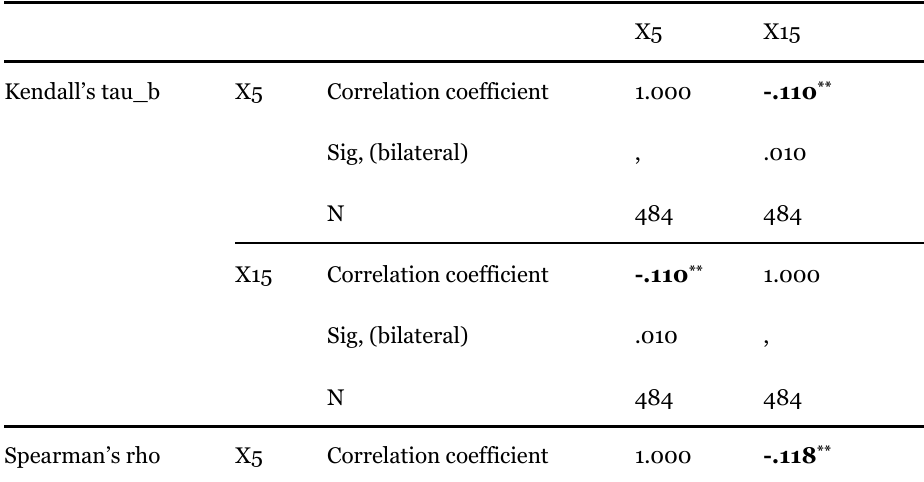
Kendall and Spearman Correlation Coefficients Between X5 (Knowledge of Sign Language) and X15 (Participation in Online